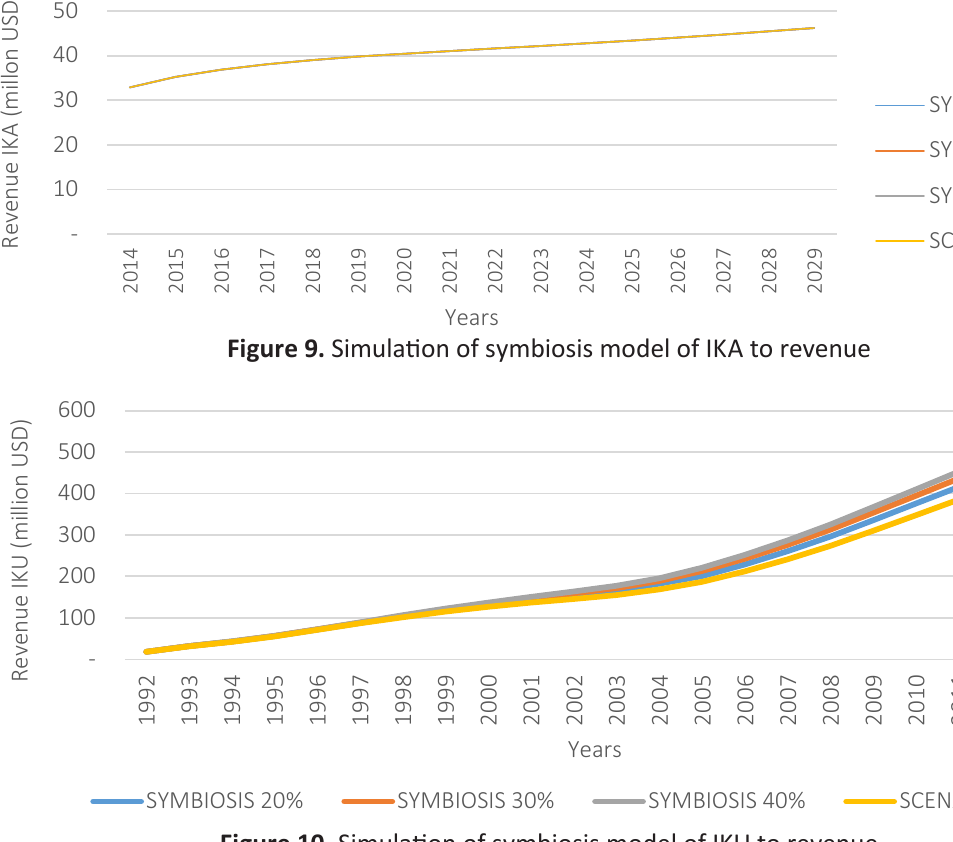
Figure 10. Simulation of symbiosis model of IKU to